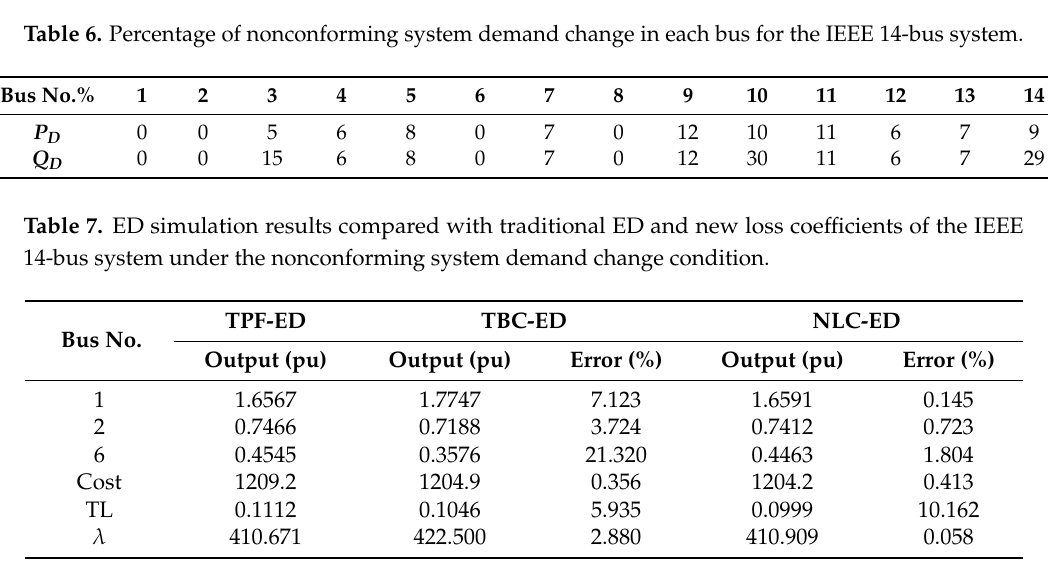
Table 8. Computing time comparison of the IEEE 14-bus